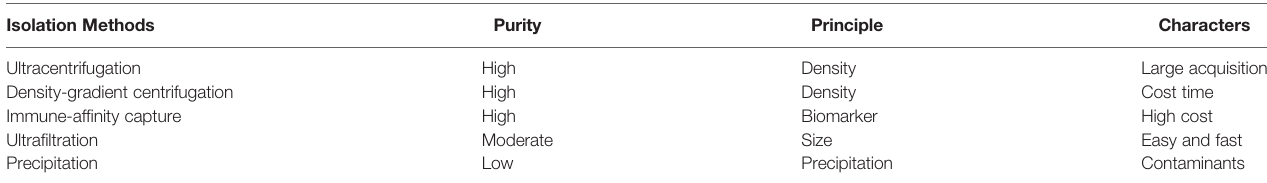
TABLE 3 | Isolation methods of